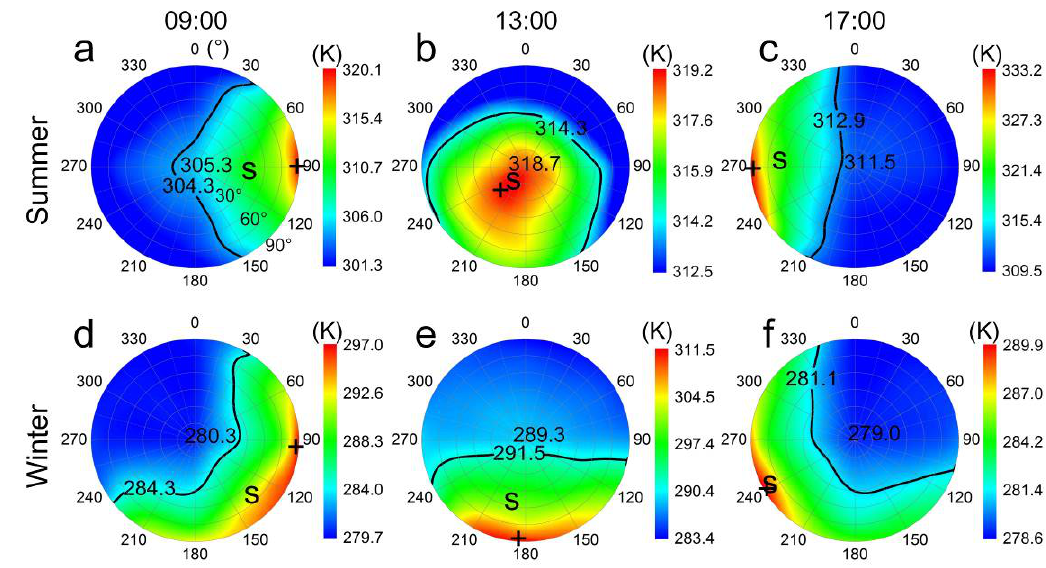
Fig.2 The polar-DRT of daytime typical time of summer and winter over the scale model (TUS03) and contour of T c (unit K). The black cross indicates the position of "hot spot", the "S" indicates the position of sun. And, (a), (b) and (c) are in summer, (d), (e) and (f) are in winter, the zenith angle and azimuth range are 0~90° and 0~360°